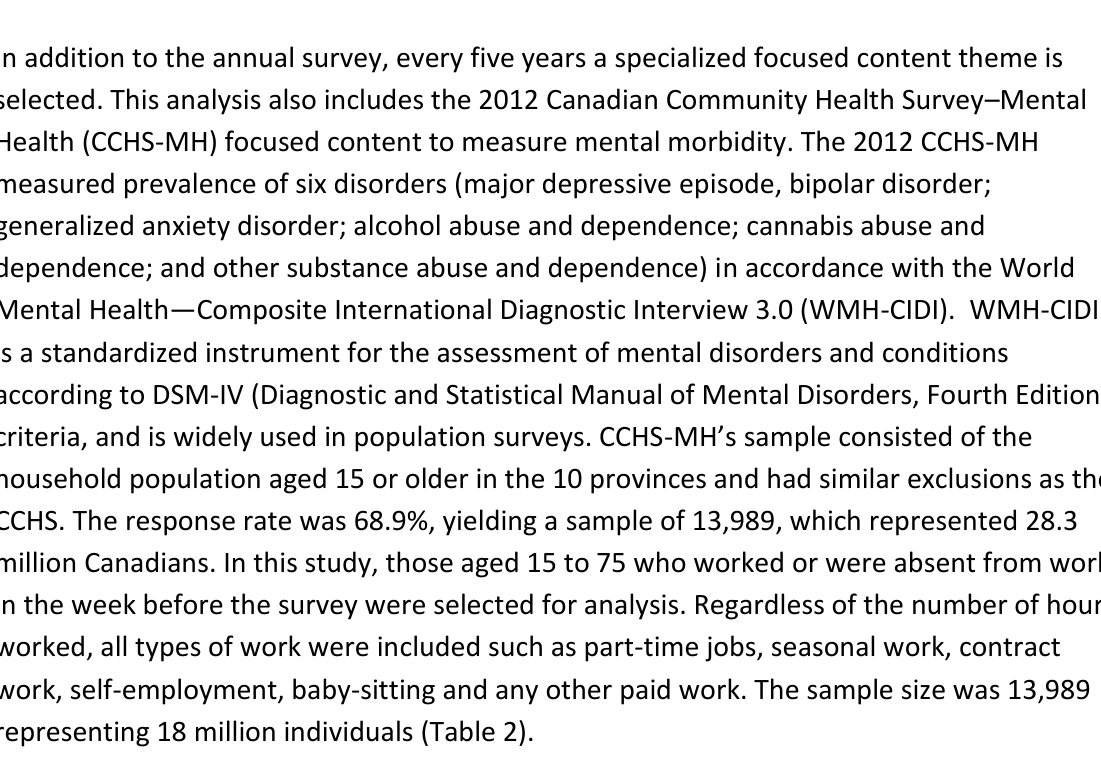
Table 2. Occupational distribution of Case study professions, aged 15+, Canada,